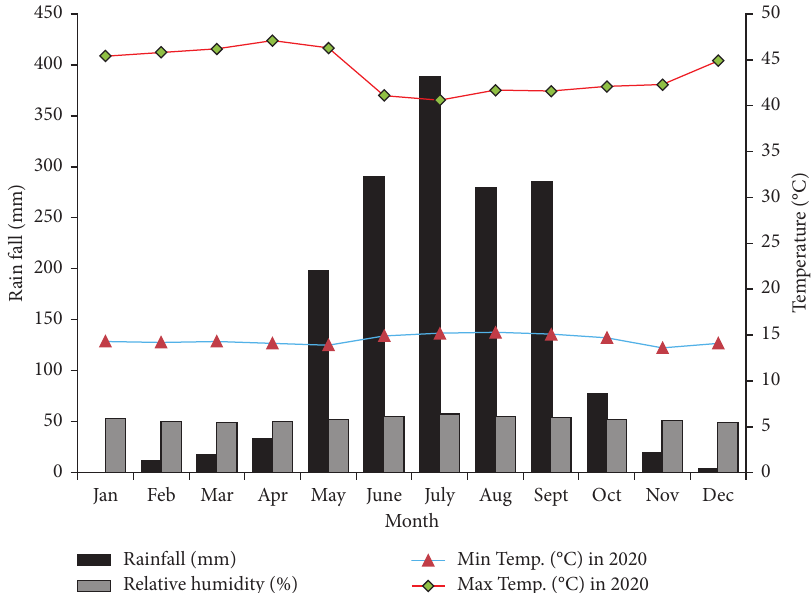
Figure 1: Monthly total rainfall (mm), relative humidity (%), and mean minimum and maximum temperatures ( ° C) of an experimental Table 1: Treatment arrangements of the experiment.